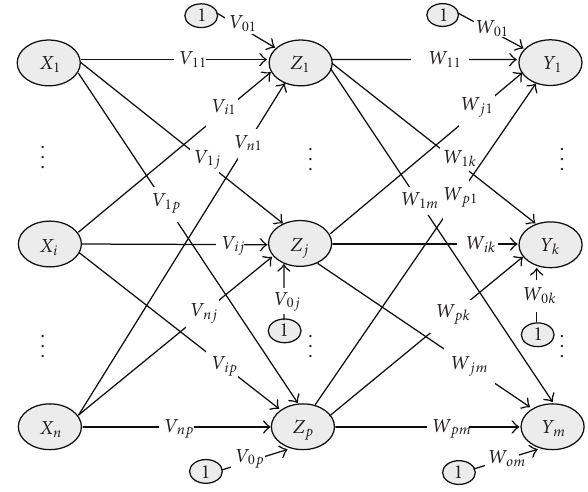
Figure 3: Two-layer BPN network